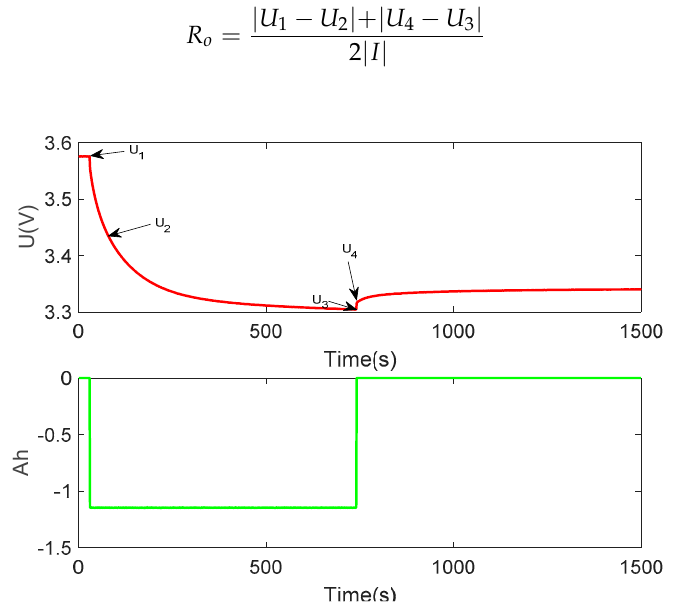
Figure 4. Terminal voltage waveform of pulsed discharge battery.